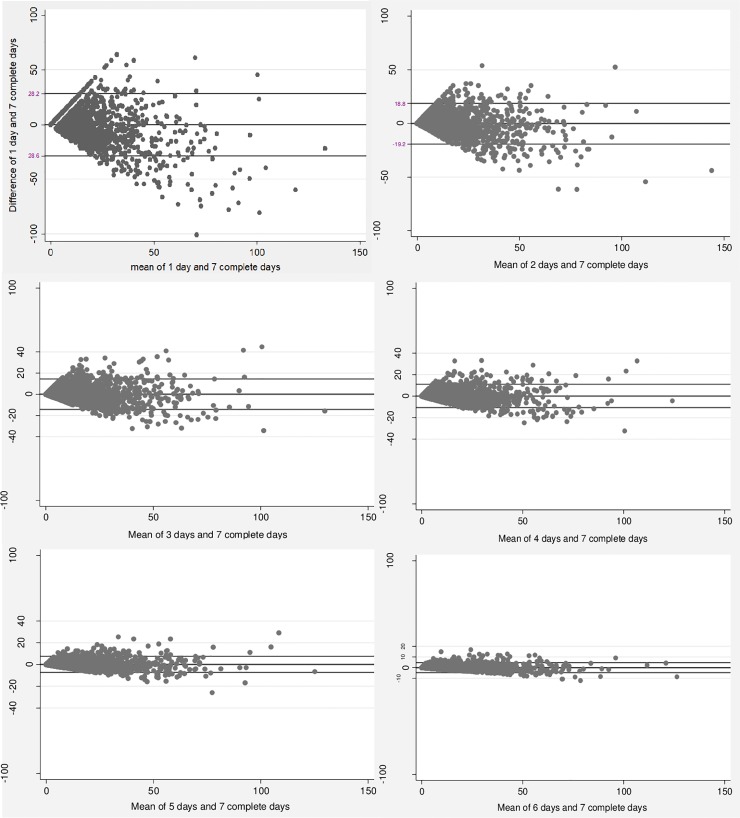
Bland-Altman plots of the comparison between the means of measurement days (1 to 6) and the standard of seven complete days of measurement for moderate-to-vigorous physical activity.